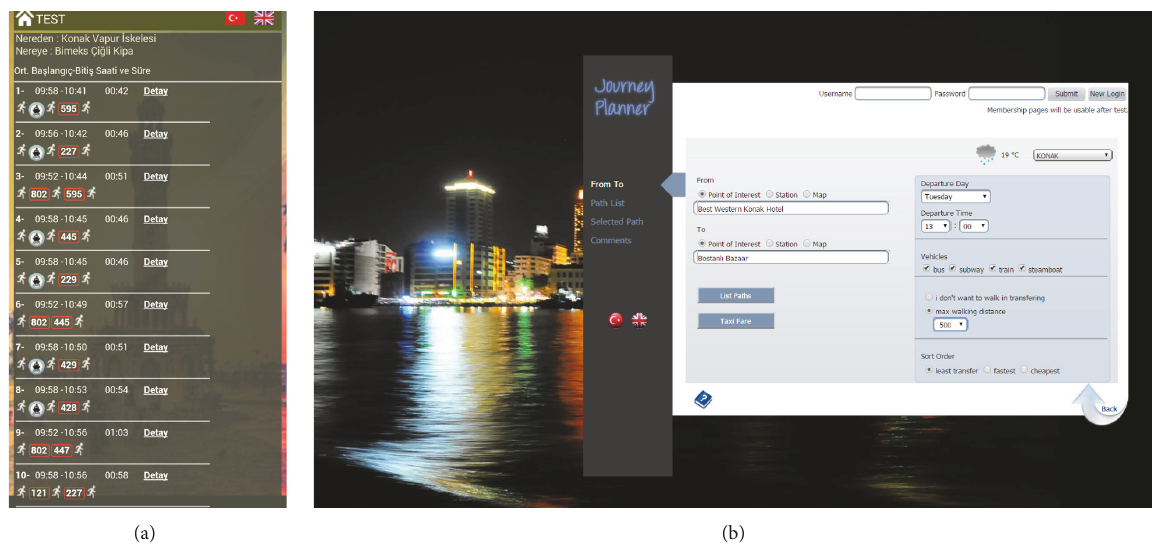
Figure 8: Sample screens from IJPS applications for (a) mobile web and (b)